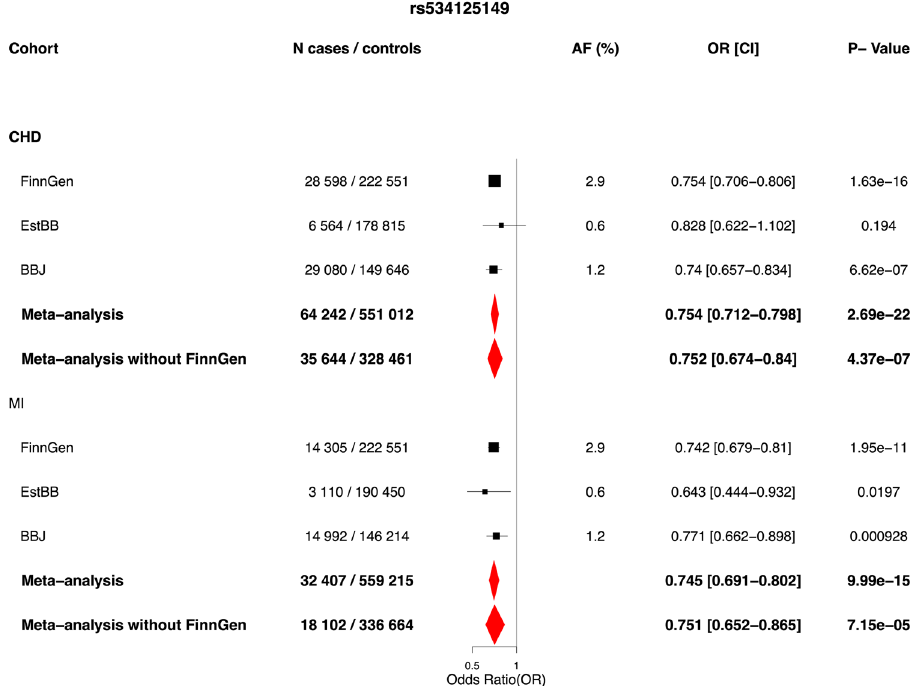
Fig. 2 Results for rs534125149 against coronary heart disease and myocardial infarction across cohorts where available and meta-analysis results. Logistic regression has been applied, adjusted for age and sex. Meta-analysis was performed using inverse-variance weighted fi xed-effects meta-analysis method. Black dots represents odds ratios, and lines 95% con fi dence interval from the the single cohorts and red diamonds represent the results from meta-analysis ends of the diamonds representing the ends of the 95% con fi dence interval. Source data for the fi gure is in Supplementary Data